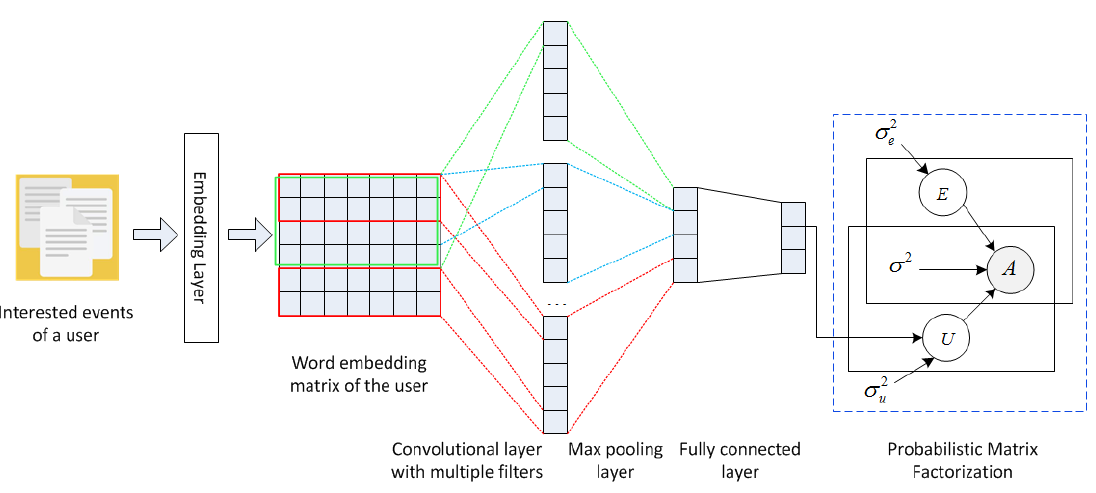
Figure 8. Architecture of